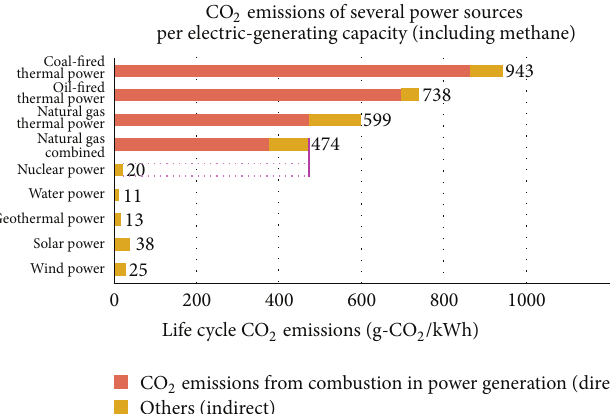
Figure 4: GHG emissions from various energy sources.